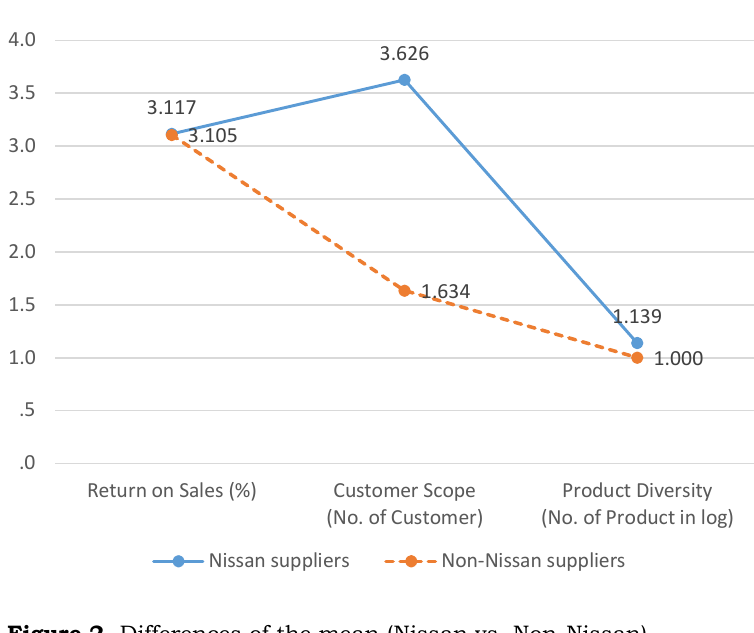
Figure 2. Differences of the mean (Nissan vs.